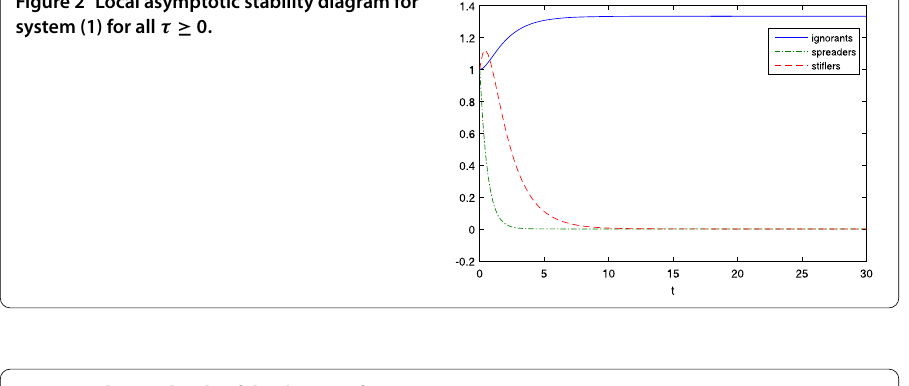
Figure 3 The amplitude of the density of spreaders with delay τ increasing ∈ [0,2.5].